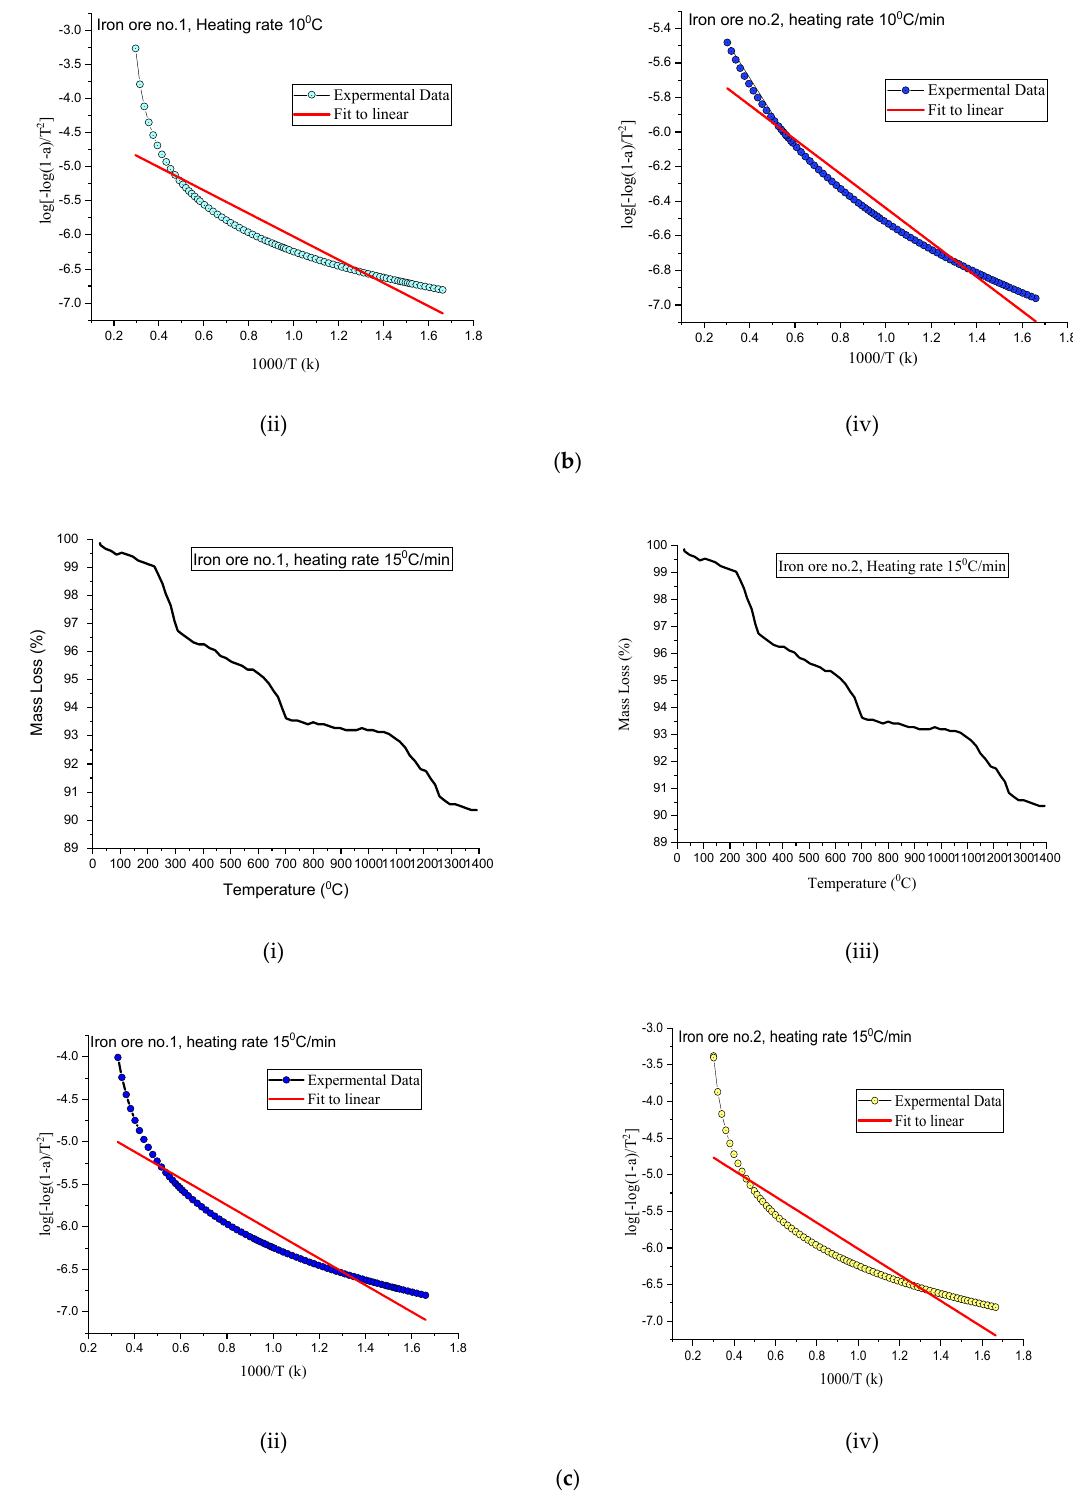
Figure 19. ( a ) Mass percentage with temperature of (i) Iron Ore No.1 and (iii) Iron Ore No.2; Experi- mental data fitting the curve of (ii) Iron Ore No.1 (iv) Iron Ore No.2 at a heating rate of 5 ◦ C/min. ( b ) Mass percentage with temperature of (i) Iron Ore No.1 and (iii) Iron Ore No.2; Experimental data fitting the curve of (ii) Iron Ore No.1 and (iv) Iron Ore No.2 at a heating rate of 10 ◦ C/min. ( c ) Mass percentage with temperature of (i) Iron Ore No.1 and (iii) Iron Ore No.2; Experimental data fitting the curve of (ii) Iron Ore No.1 and (iv) Iron Ore No.2 at a heating rate of 15 ◦